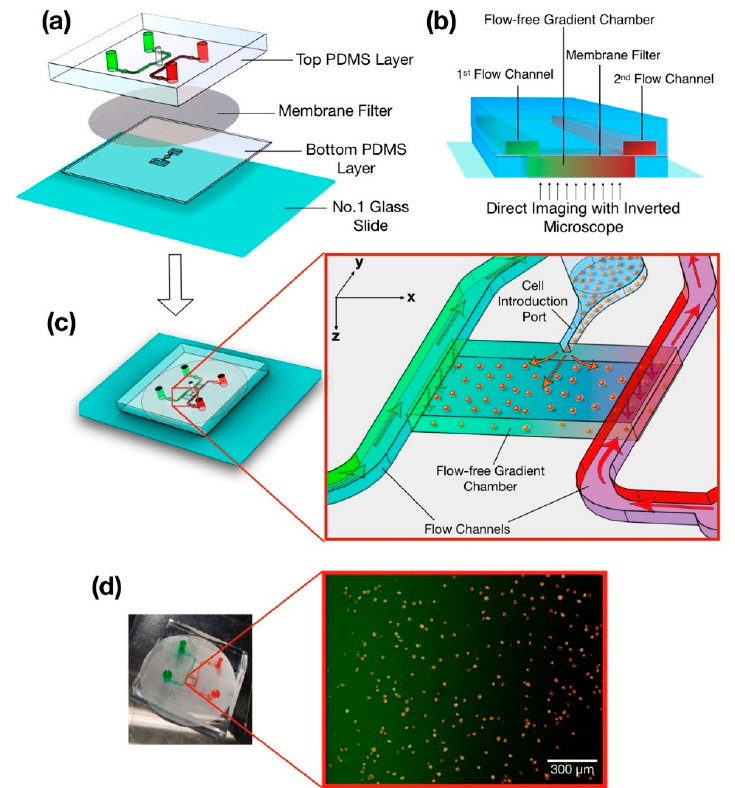
Figure 1. Chemotaxis of Jurkat cells in microfluidic flow-free gradient chambers. (a) An enlarged view of microfluidic flow-free gradient generator. The top PDMS (polydimethylsiloxane) layer had two parallel flow channels and a cell introduction port that was connected to bottom PDMS layer with a membrane filter. The entire assembly was attached to a thin glass coverslip at the bottom to enable high numerical aperture imaging. (b) Schematic of the flow-free gradient chamber approach. Soluble species diffused through the membrane to the bottom layer creating linear concentration gradients in the flow-free gradient chambers. (c) Schematic of the microfluidic device after assembly. (inset) The introduction of cells into the gradient chamber through the cell introduction port and the generation of a gradient across the cells. (d) Image of the actual microfluidic device where flow channels were filled with dye for visualization after fabrication. (inset) Composite fluorescent image taken from the flow-free-gradient chamber where the Jurkat cells were in a linear concentration gradient of FITC- Dextran.